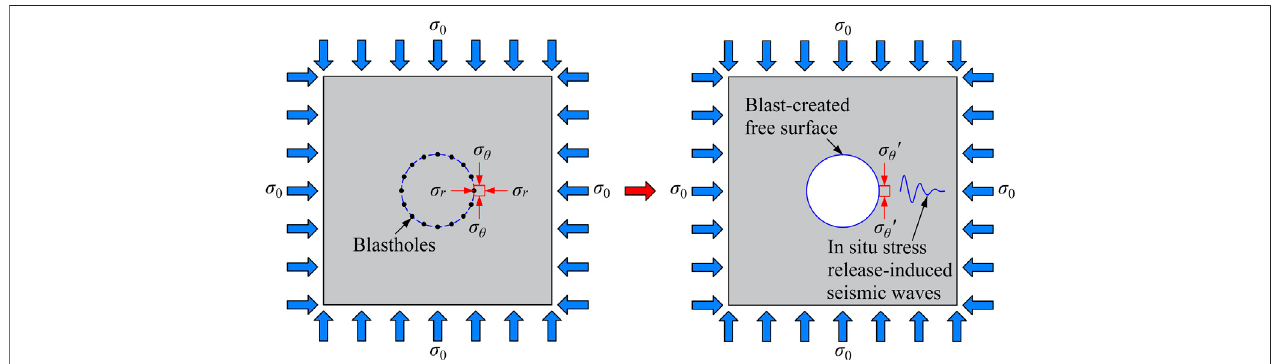
FIGURE 1 | Diagram of the rapid in situ stress release occurring on blast-created free surfaces.